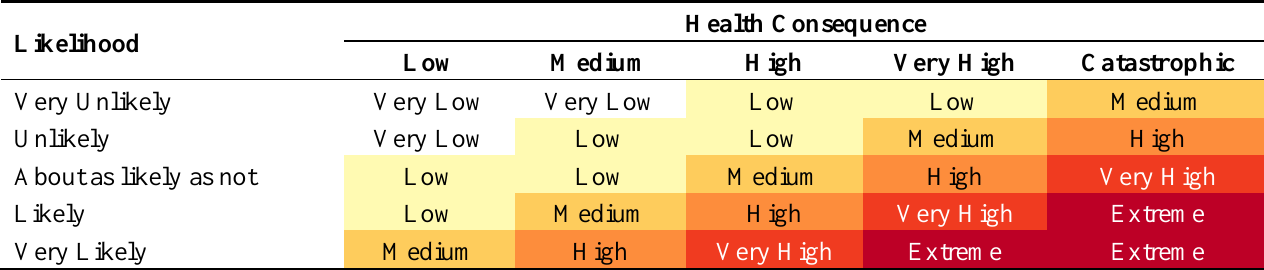
Table 3. Risk assessment matrix and final risk